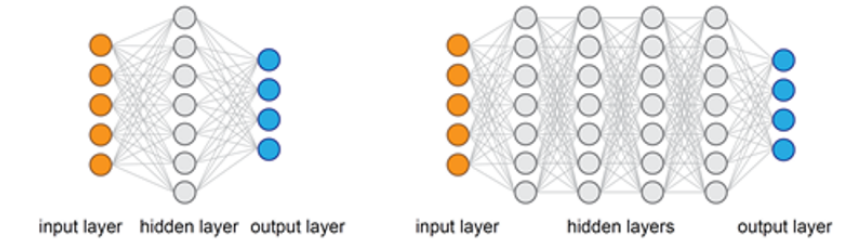
Figure 3. A visual representation of a deep neural network ( right ) and a shallow neural network ( left